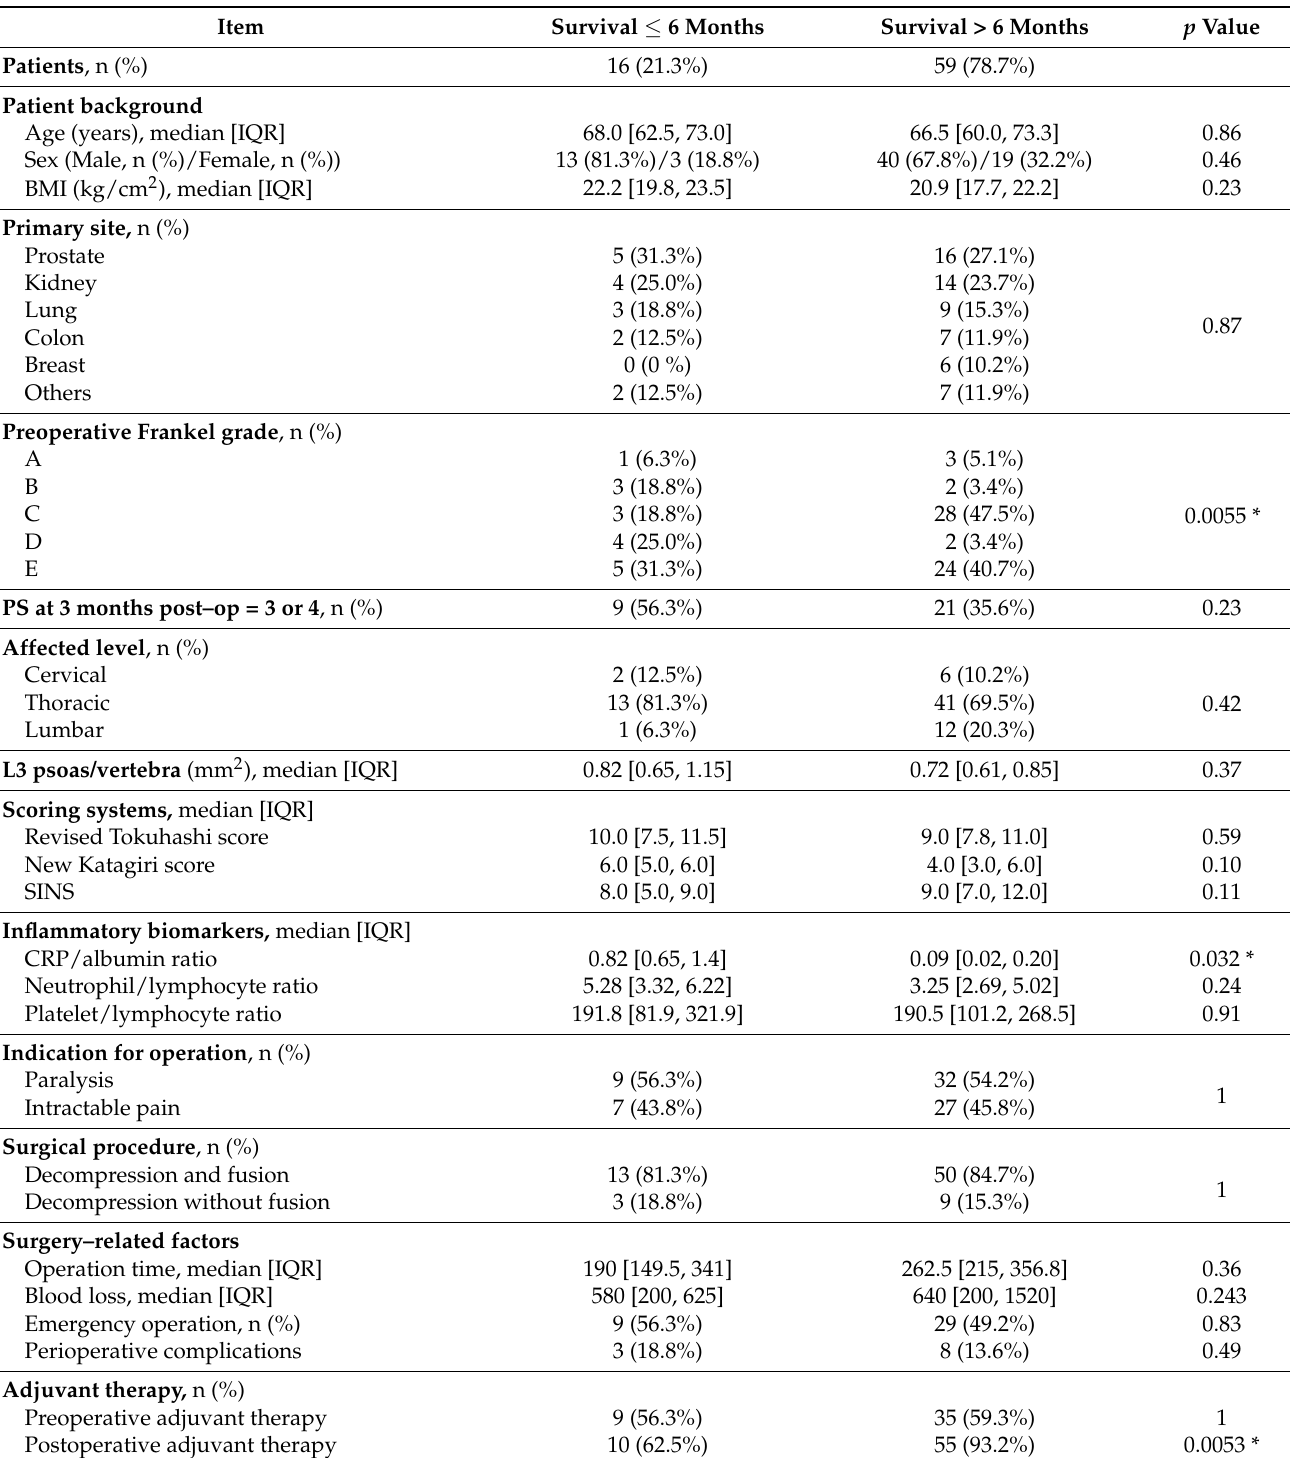
Table 3. Comparison of patients with and without survival >6 months after palliative